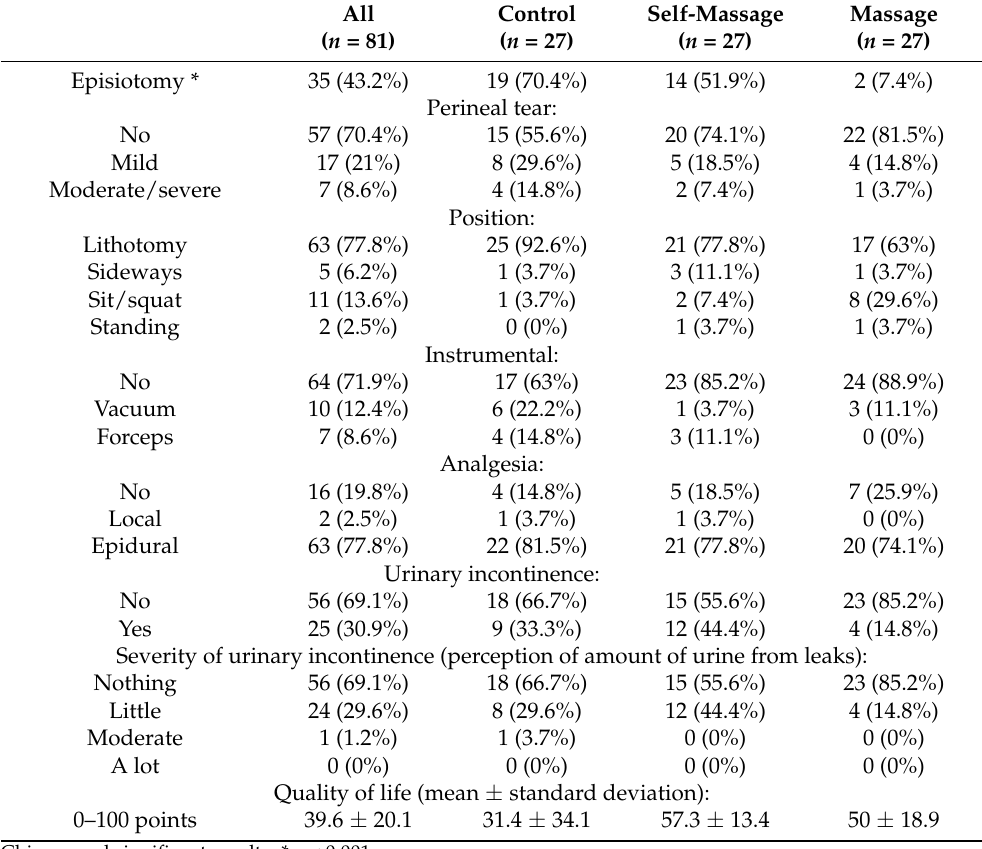
Table 2. Delivery and urinary incontinence characteristics [data provided: n (percentage)].